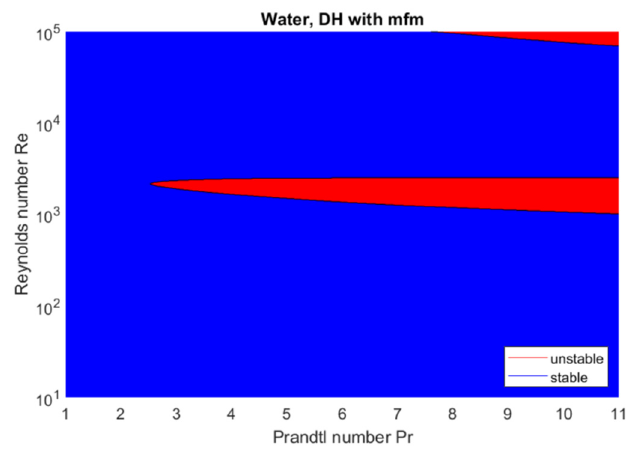
Fig. 6. DYNASTY stability map example: distributed heating configuration, water as working